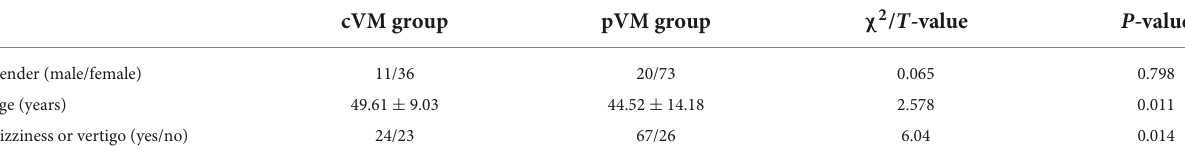
TABLE 3 Clinical data of the cVM and pVM